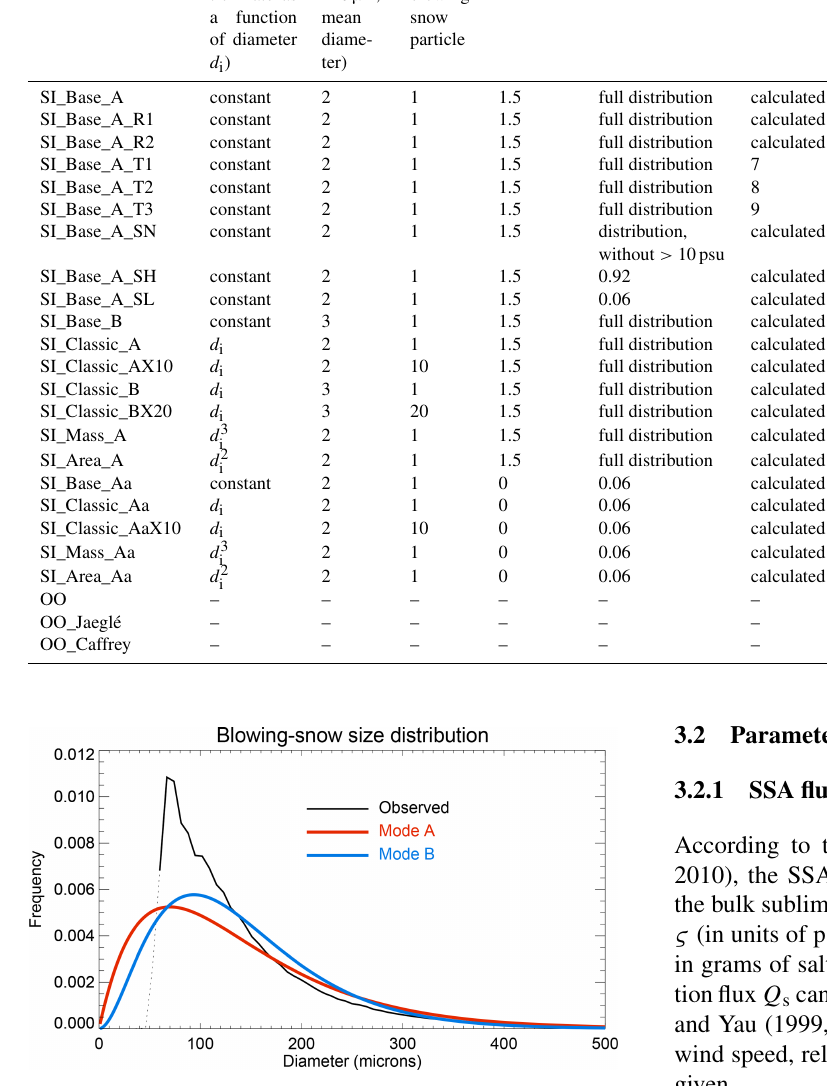
Figure 2. Normalized 29m SPC instrumental blowing-snow size distribution is shown by the black line. Note that the dotted line is for small particles with a diameter < 60µm. Two blowing-snow size distribution functions are derived for model usage with mode A (red line) having a shape value α = 2 with β = 70µm and mode B (blue line) having α = 3 with β = 46 . 7µm (fixed mean diame- ter = 140µm). The X -axis interval is